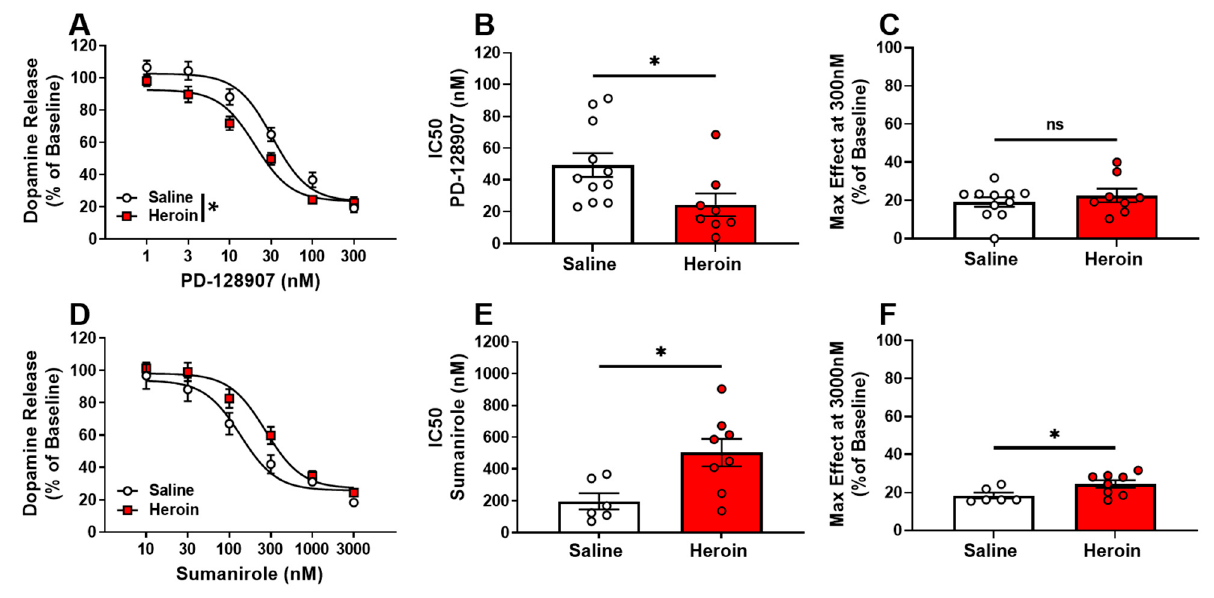
Figure 3. Opposite adaptations of D2 and D3 autoreceptors following heroin self-administration. Concentration-response curves for the selective D3 agonist, PD-128907, and selective D2 agonist, sumanirole, were used to evaluate autoreceptor responsivity. Heroin-exposed animals displayed increased agonist-induced responsivity of D3 autoreceptors ( A ), and a significantly lower IC50 in heroin-exposed animals ( B ), indicating increased agonist potency and no significant differences in PD-128907 maximal effect (at 300 nM), indicating no change in the maximal efficacy of the agonist ( C ). Selective D2 agonist, sumanirole, concentration-response curves ( D ) indicated a significantly greater IC50 ( E ) and maximal effect of sumanirole ( F ) in heroin-exposed rats. * p < 0.05; ns: not significant.